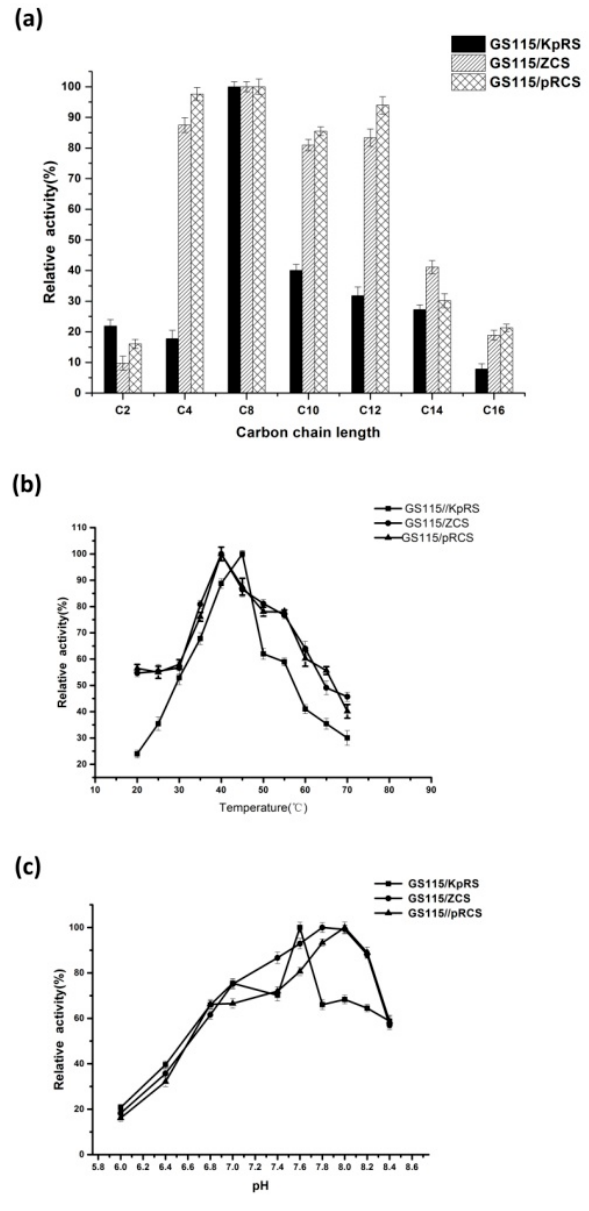
Figure 4. Characteristics of the displayed targeted lipases Rhizopus oryzae lipase (ROL) and Candida rugosa lipase 1 (CRL1). ( a ) Effects of substrate specificity on single-displayed ROL and CRL1 and codisplayed lipases on Pichia pastoris strains. Bioactivity was measured by spectrophotometry at 40 °C in 10 mM acetonitrile containing C2, C4, C8, C10, C12, C14, and C16 p -nitrophenol esters. The optimal substrate for single-displayed ROL and CRL1 and codisplayed lipases was pNP-octanoate (C8). ( b ) Effects of temperature on single-displayed ROL and CRL1 and codisplayed lipase activity on P. pastoris strains. Surface-displayed lipase activity at 20 °C–70 °C was measured at pH 8.0 for 10 min. Relative activity was calculated by comparing bioactivity on pNP-octanoate (C8) substrate at 40 °C and pH 8.0. The optimal temperature was 45 °C for ROL on GS115/KpRS. The optimal temperature was 40 °C for CRL1 on GS115/ZCS and codisplayed lipases on GS115/pRCS. Data are means ± standard deviations (SDs) of three independent tests. ( c ) Effects of pH on single-displayed ROL and CRL1 and codisplayed lipase activity on P. pastoris strains. Effects of pH on single-displayed and codisplayed lipase activity were determined by comparing the original bioactivity on pNP-octanoate (C8) at 40 °C and pH 6.0–8.5 for 10 min. The optimal pH values were 7.6, 7.8–8.0, and 8.0 for single-displayed ROL and CRL1 and codisplayed ROL plus CRL1 on GS115, respectively. Data are means ± SDs of three independent tests.